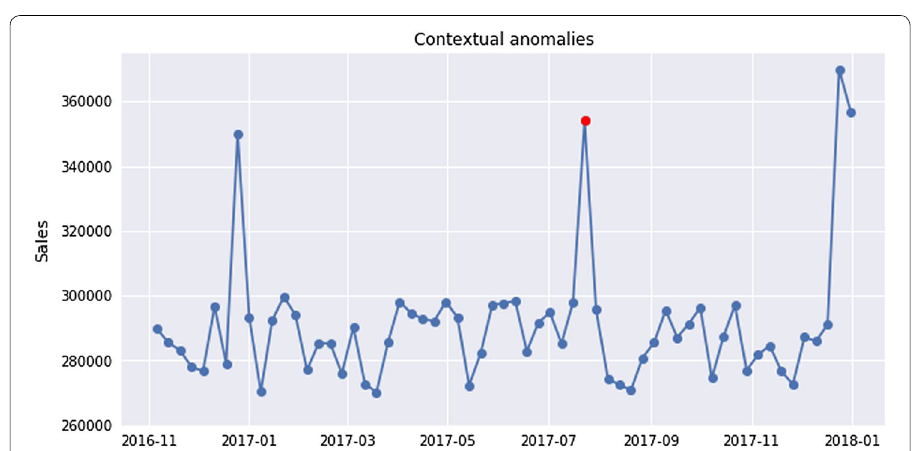
Fig. 5 Contextual anomaly example